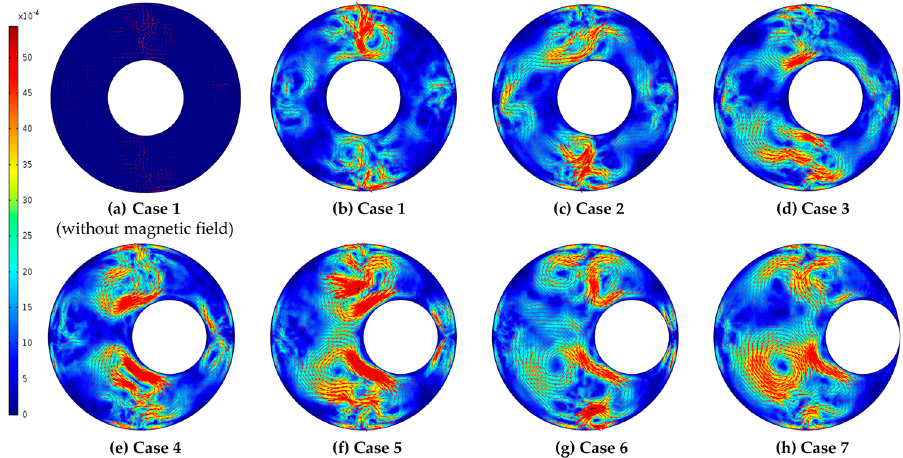
Figure 4. Velocity distributions with various eccentricity conditions for the case of H = 10 kA/mm.